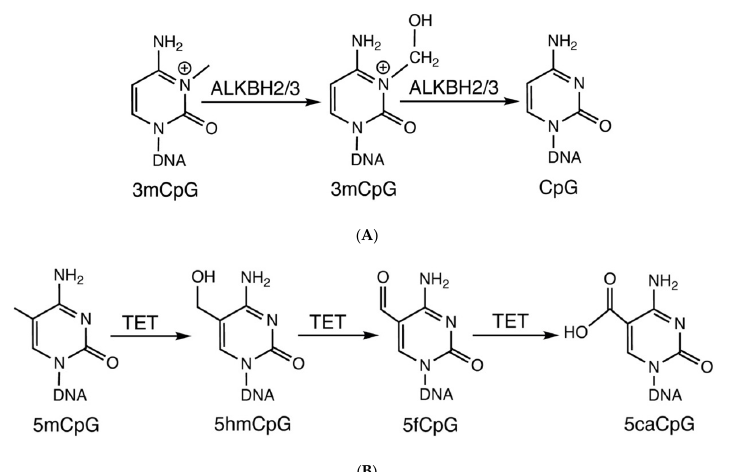
Figure 2. ( A ). Schematic representation of direct demethylation of 3mC by ALKBH2, 3 dioxygenases; ( B ) Schematic representation of oxidative demethylation of 5mC by TET family dioxygenases.